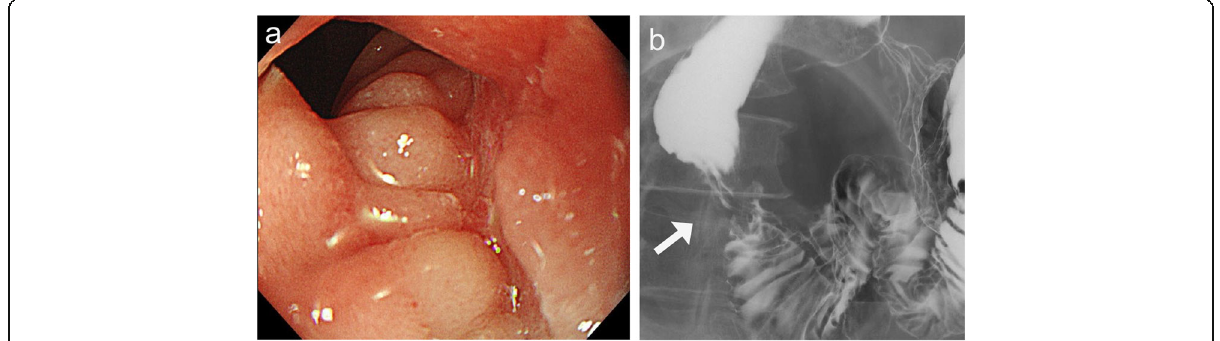
Fig. 5 a , b Upper gastrointestinal endoscopy and X-ray radiography after chemotherapy also showed the decreased size of the ulcerative duodenal tumor (arrow)